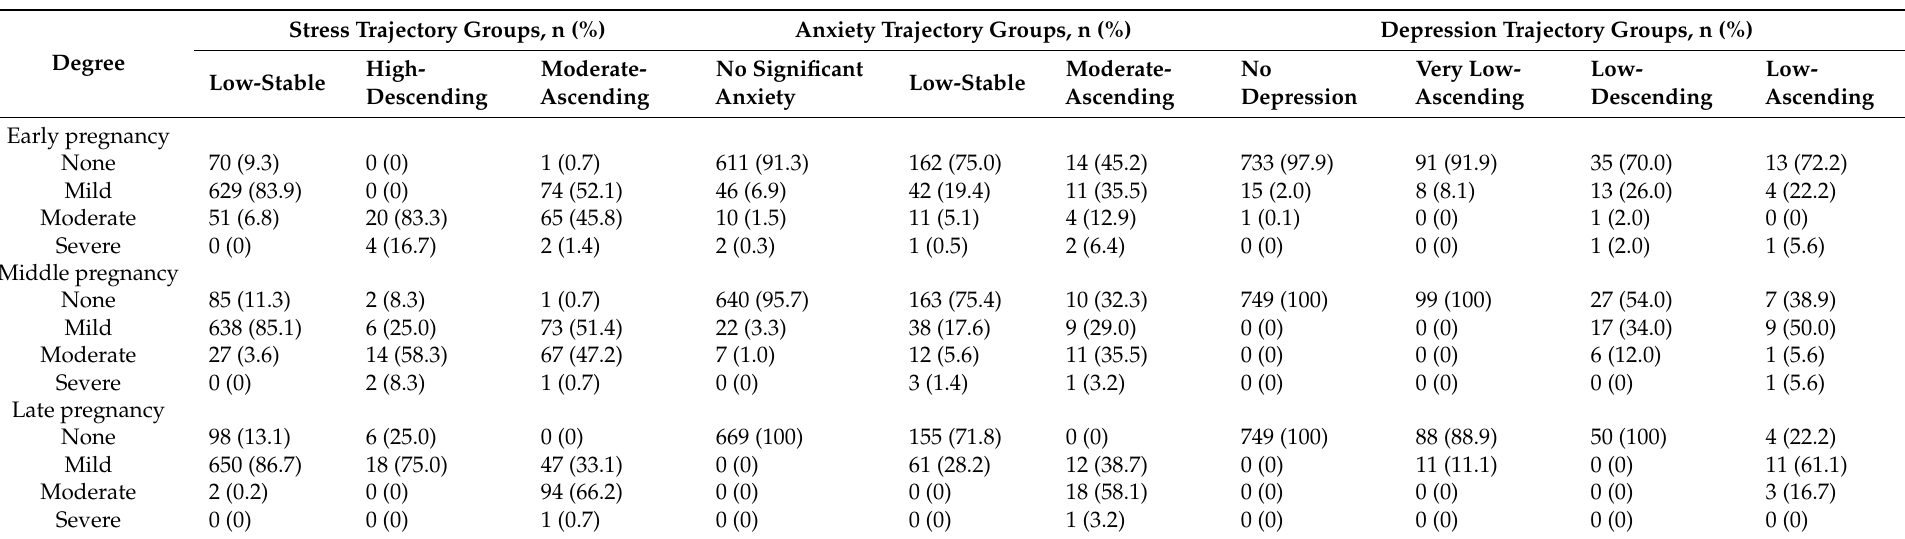
Table 3. Distributions of symptom levels in the stress, anxiety, and depression trajectory subgroups at each follow-up